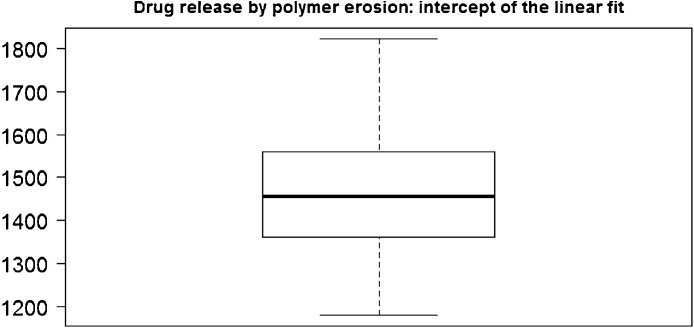
Distribution of the values of the intercept a of the linear fit for N(t) given in Eq. (5) obtained in 50 simulation runs.